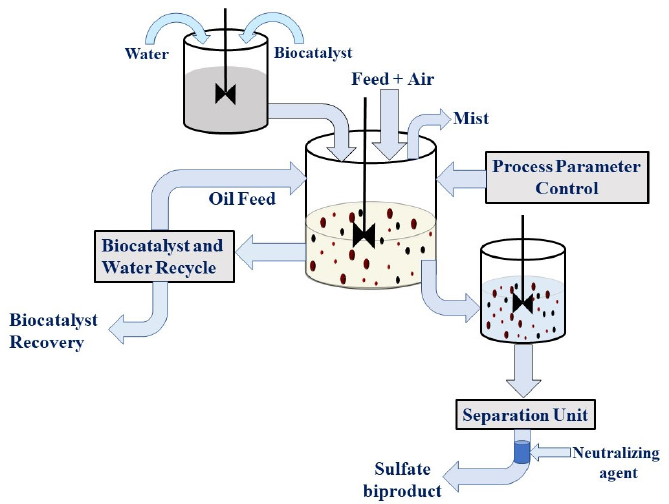
Figure 3. Typical refining technology hydrodesulfurization plan illustrating desulfurization pro ‐ cessing sequences. Table 2. Aromatic sulfur species found in petroleum and their boiling